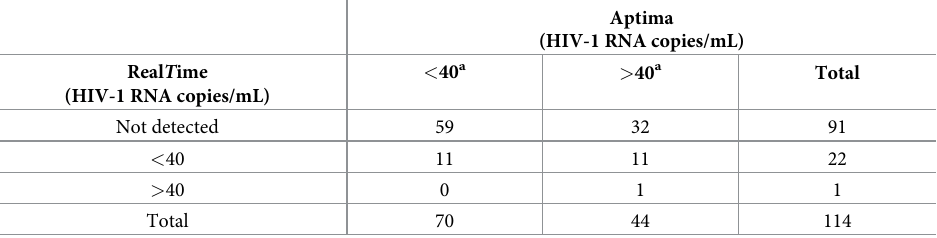
Table 1. Comparison of VL values obtained with Aptima ( pol and LTR dual-target) and Real T ime ( pol single-tar- get) in 114 samples with viremia quantified with LTR region.